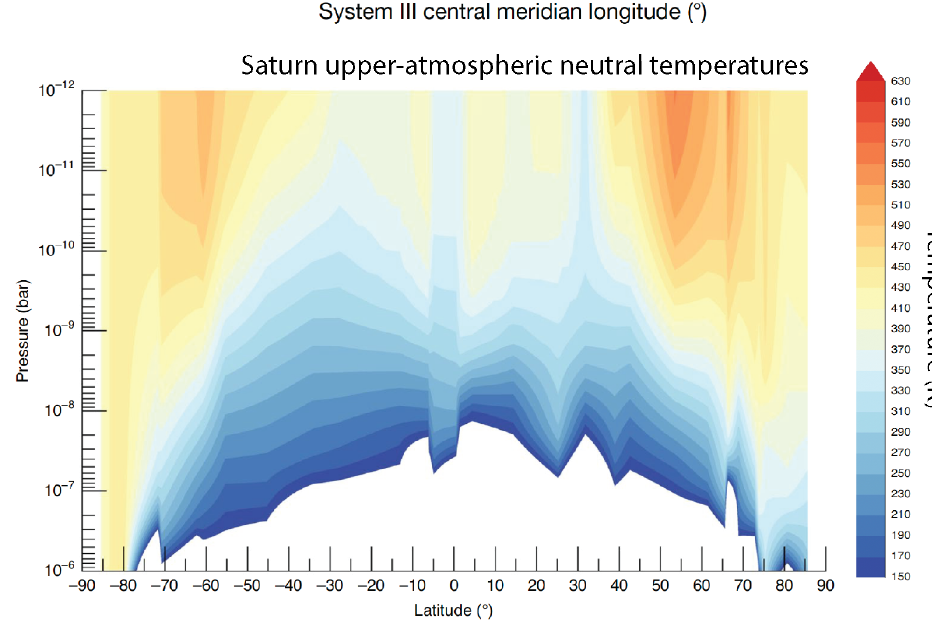
Figure 8. Observed upper-atmospheric temperatures at Jupiter and Saturn. ( Top ): equirectangular projection of Jupiter’s altitudinally column-integrated H + temperature as a function of central 3 meridian longitude (Jovian system III) and planetocentric latitude, adapted from [94]. Long black-and- white dashed lines show Jupiter’s main auroral oval, short black-and-white dashed lines correspond to the magnetic footprint of Io, and the single thick black line corresponds to the magnetic footprint of Amalthea. Temperatures have uncertainties below 5%. ( Bottom ): Saturn’s meridional temperature profile as a function of altitude and pressure (altitude) adapted from